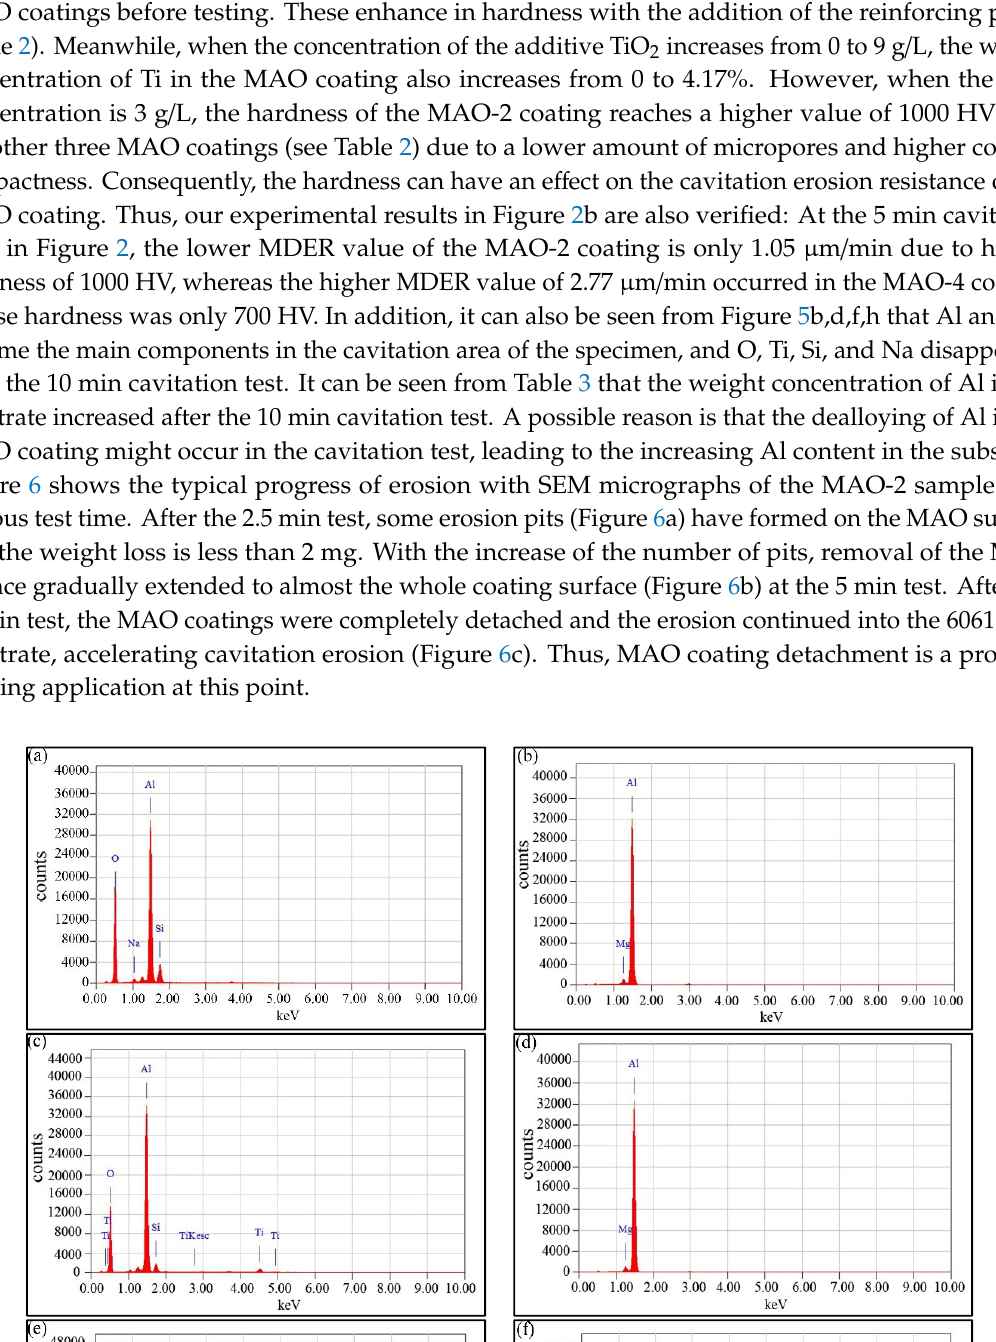
Table 3. Weight concentration (wt.%) of MAO coating surfaces before and after test.